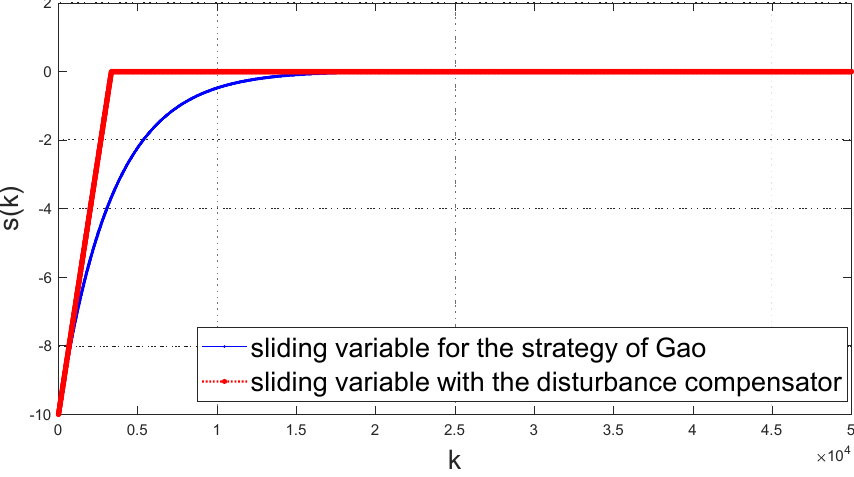
Figure 2. Comparison of the discrete-time sliding variables.